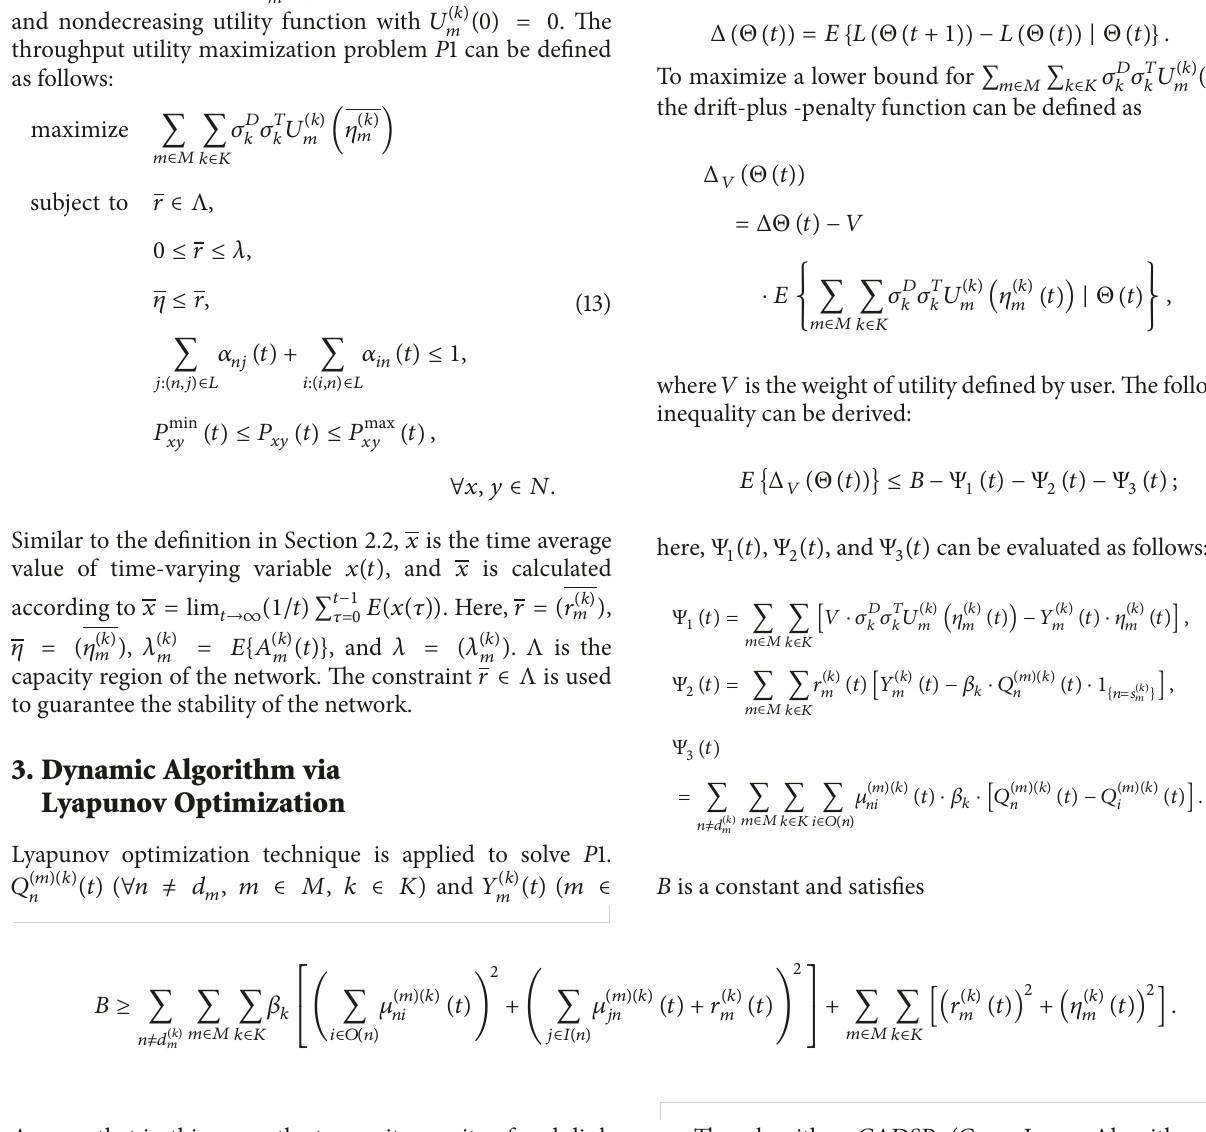
The algorithm CADSP (Cross-Layer Algorithm with Differentiated Service Prioritization) scheme is based on the drift-plus-penalty framework [17]. The main design principle of the algorithm is to minimize the right-hand side of